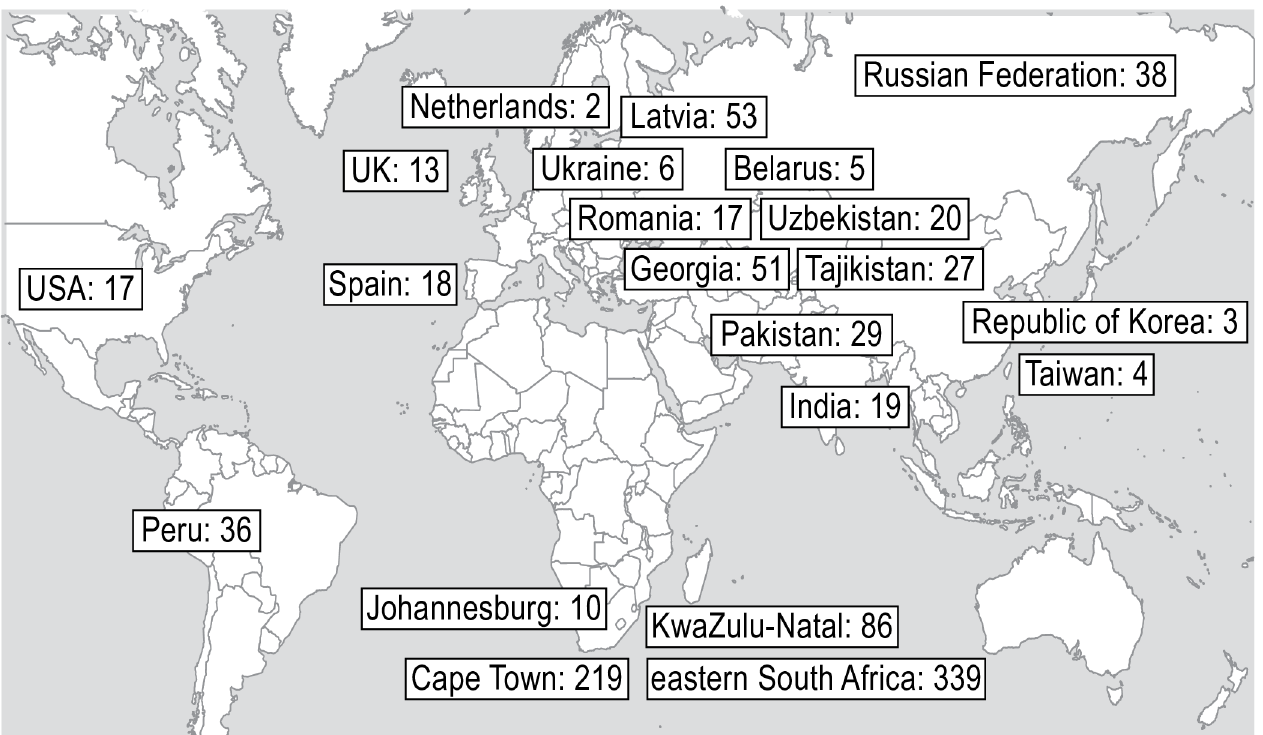
Fig 2. Geographic distribution of patients. Locations of patients included in the individual patient data meta-analysis. The number indicates the number of participants included from each location.